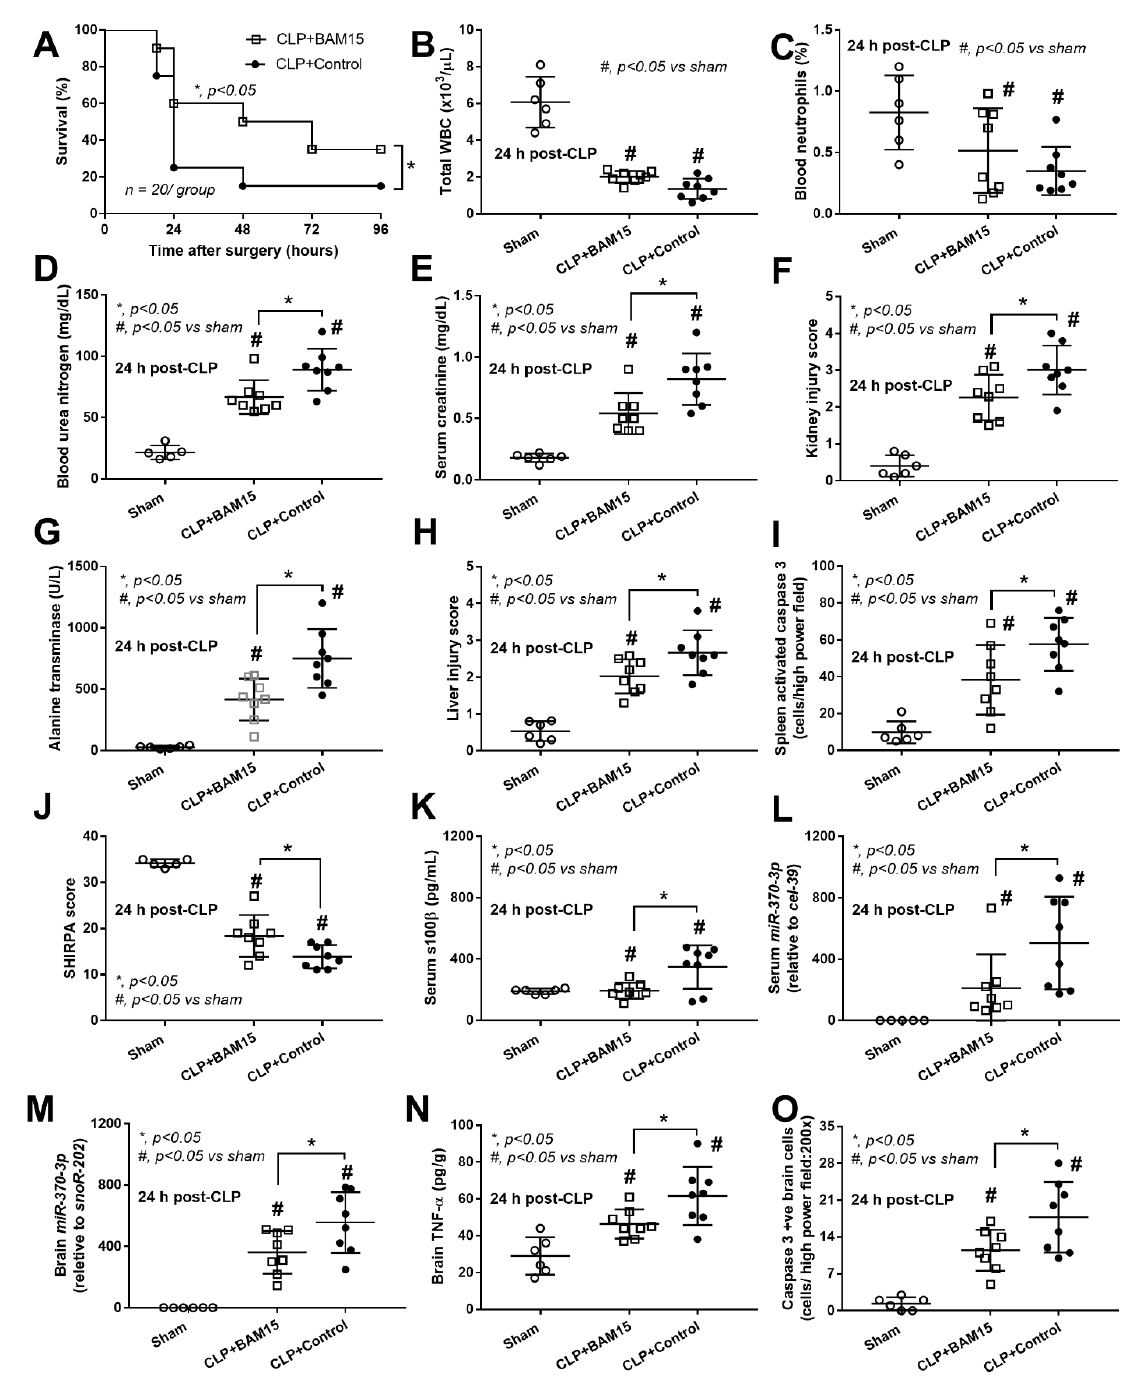
Figure 1. Characteristics of cecal ligation and puncture (CLP) sepsis or sham mice at 24 h after surgery with BAM15 or vehicle (control) as evaluated by survival analysis ( n = 20/group) ( A ), total white blood cell (WBC) and neutrophils in peripheral blood ( B , C ), renal function (blood urea nitrogen, serum creatinine, and kidney histological score) ( D – F ), liver injury (alanine transaminase and liver histological score) ( G , H ), spleen apoptosis (activated caspase 3) ( I ), encephalopathy clinical score (SHIRPA score; see Methods) ( J ), and encephalopathy parameters in serum (S100 β and miR370-3p) ( K , L ), brain miR370-3p, brain TNF- α , and brain apoptosis (activated caspase 3) ( M – O ) are shown ( n = 6–8/group). #, p < 0.05 vs. sham; * p < 0.05 vs. the indicated groups as determined by ANOVA with Tukey’s analysis. The survival analysis is calculated by Log -rank test. Data from sham mice with BAM15 are not demonstrated due to the non-significant difference to the sham group.